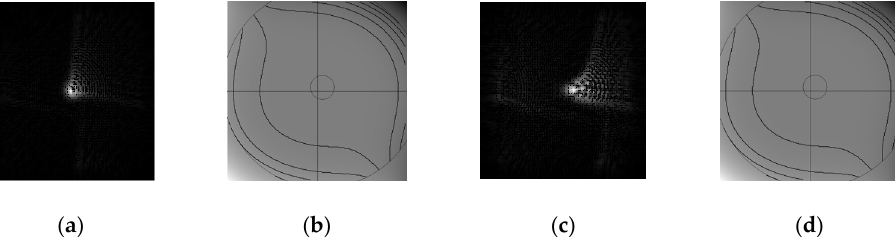
Figure 13. A beam amplitude registered at the distance of 0.1 diffraction length ( a ) and its initial phase ( b ) represented as the sum of the first nine polynomials. All polynomial coefficients except No. 9 were equal to one; the ninth coefficient was equal to 0.2. Amplitude ( c ) and phase ( d ) profiles obtained as a result of approximation with the use of eight polynomials.